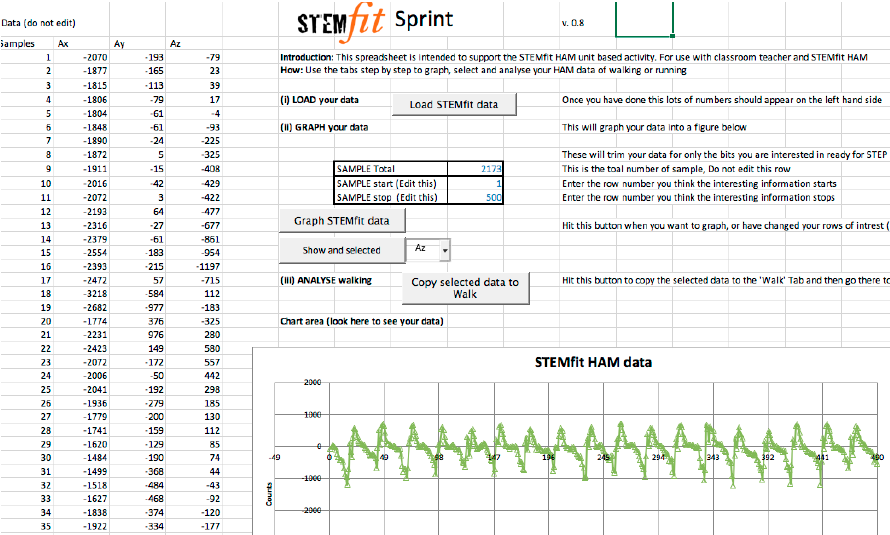
Figure 2. A sample education spreadsheet showing raw inertial sensor data and student-led inquiry process. Additional ‘tabbed’ sheets (not shown) show processed data with metrics such as jump height and stride time that can be used to compare performance across the classroom and with other